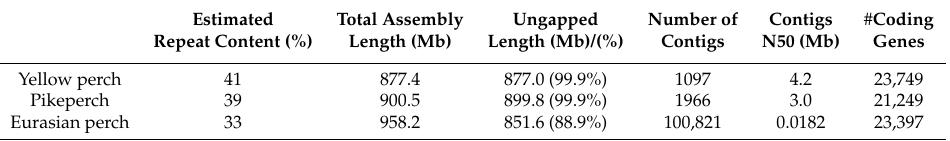
Table 3. Comparison of currently reported genome assemblies of fish species in the Percidae family.